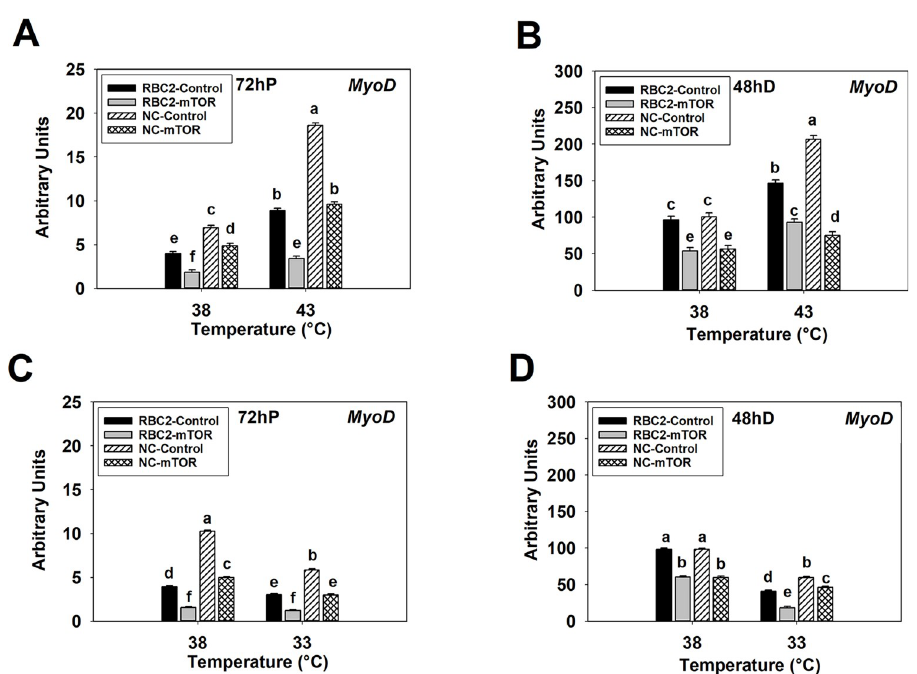
Fig 7. Effect of heat or cold thermal stress and siRNA-mediated knockdown of mTOR at the beginning of proliferation on the expression of MyoD in RBC2 and NC line SCs. After transfection with either a negative control siRNA (Control) or a siRNA targeting mTOR (mTOR), SCs proliferated at 38˚ or 43˚C for 72 h (A) followed by 48 h of differentiation (B). After transfection with either a negative control siRNA (Control) or a siRNA targeting mTOR (mTOR), SCs proliferated at 38˚ or 33˚C for 72 h (C) followed by 48 h of differentiation (D). Each graph bar represents a mean arbitrary unit, and each error bar represents a standard error of the mean. Mean values without a same letter are significantly different ( P �